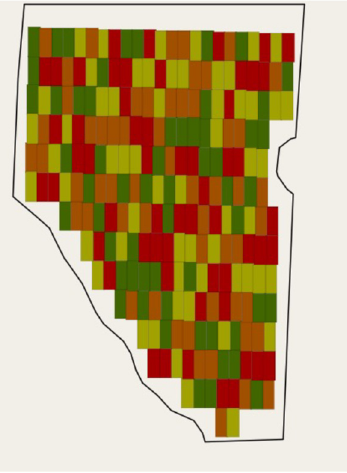
Figure 1. Conceptual diagram of an example experimental layout in the OFPE methodology. Different colors represent different rates of the agronomic input.